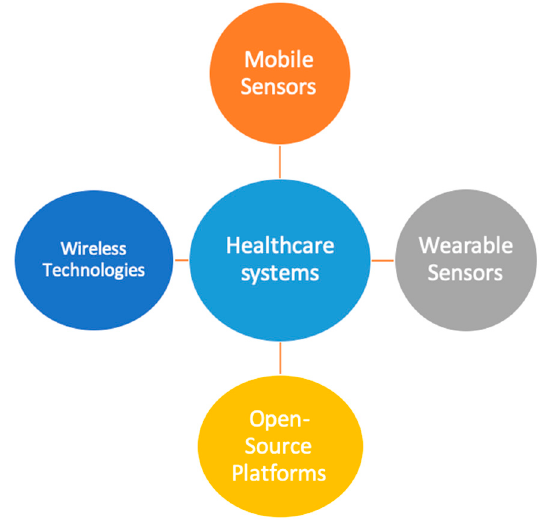
Figure 1. Important areas of research for healthcare systems.